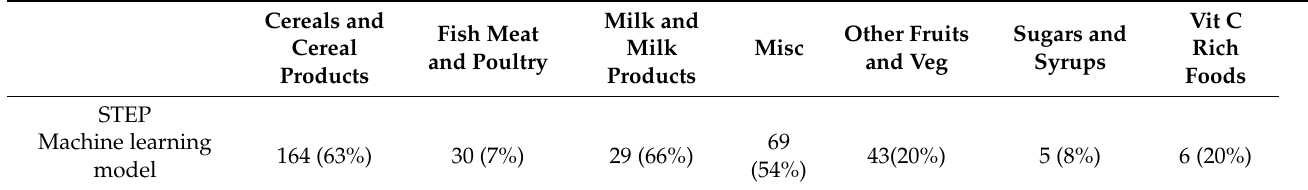
Table 3. Number of foods imputed with the machine learning model, by food group.